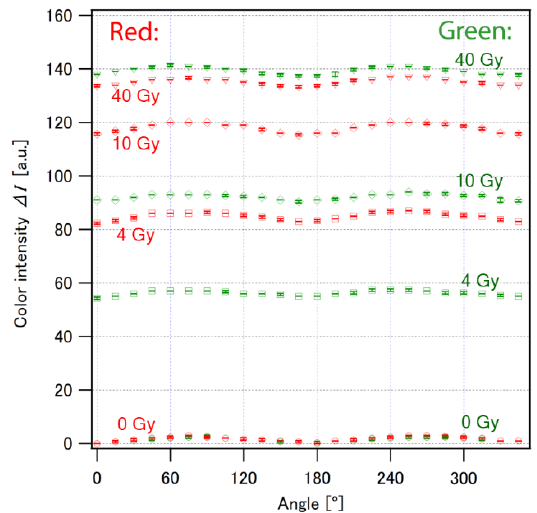
Figure 4. Angle dependences of the color intensities as to the red and green components of EBT-XD measured with Nix with 15° intervals after irradiation with 160 kV X-rays at 0 (control), 4, 10 and 40 Gy.